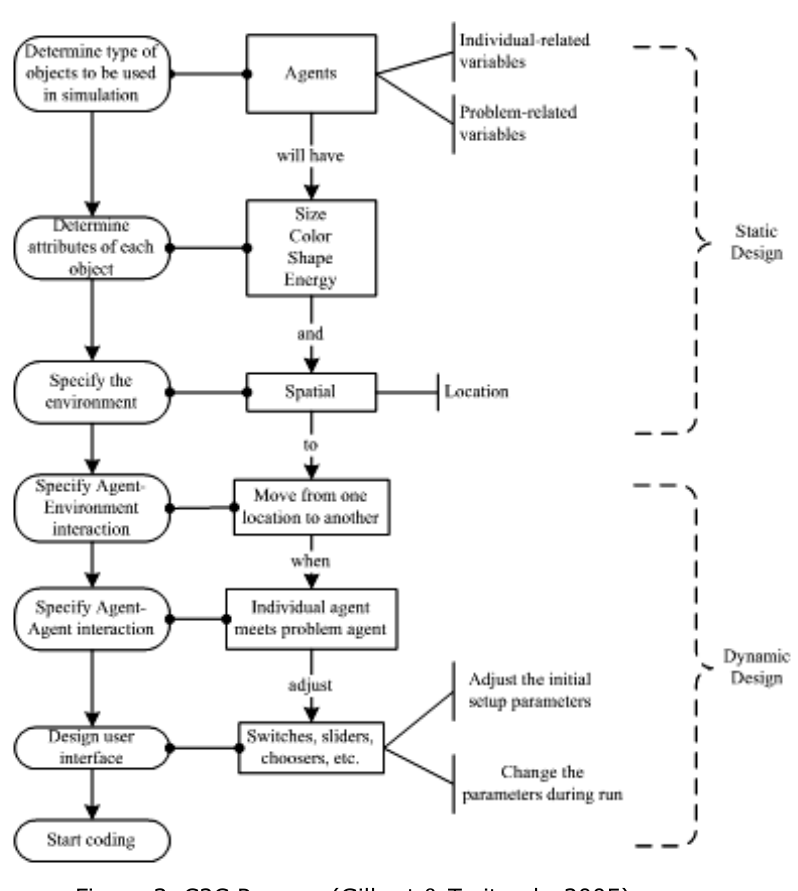
Figure 3. C2C Process (Gilbert & Troitzsch,